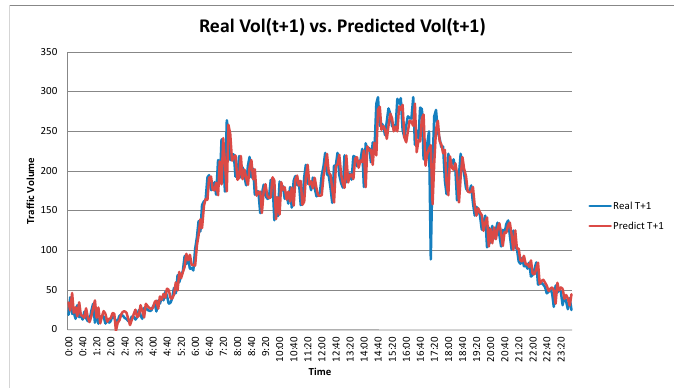
Figure 5. The estimated volume matches the real one perfectly.